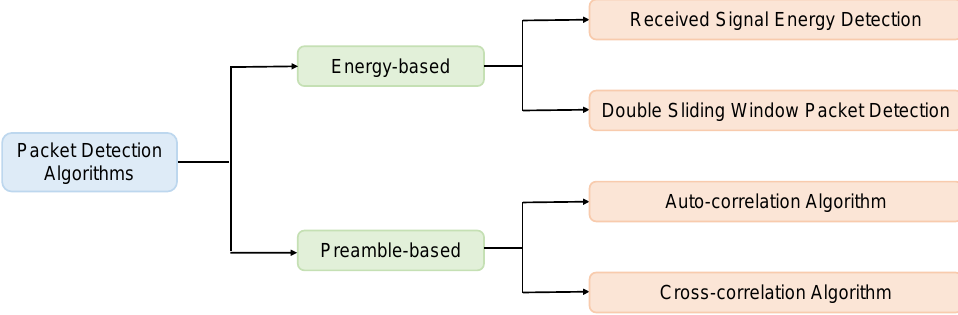
Figure 4. The classification of packet detection algorithms for 802.11 OFDM signals.